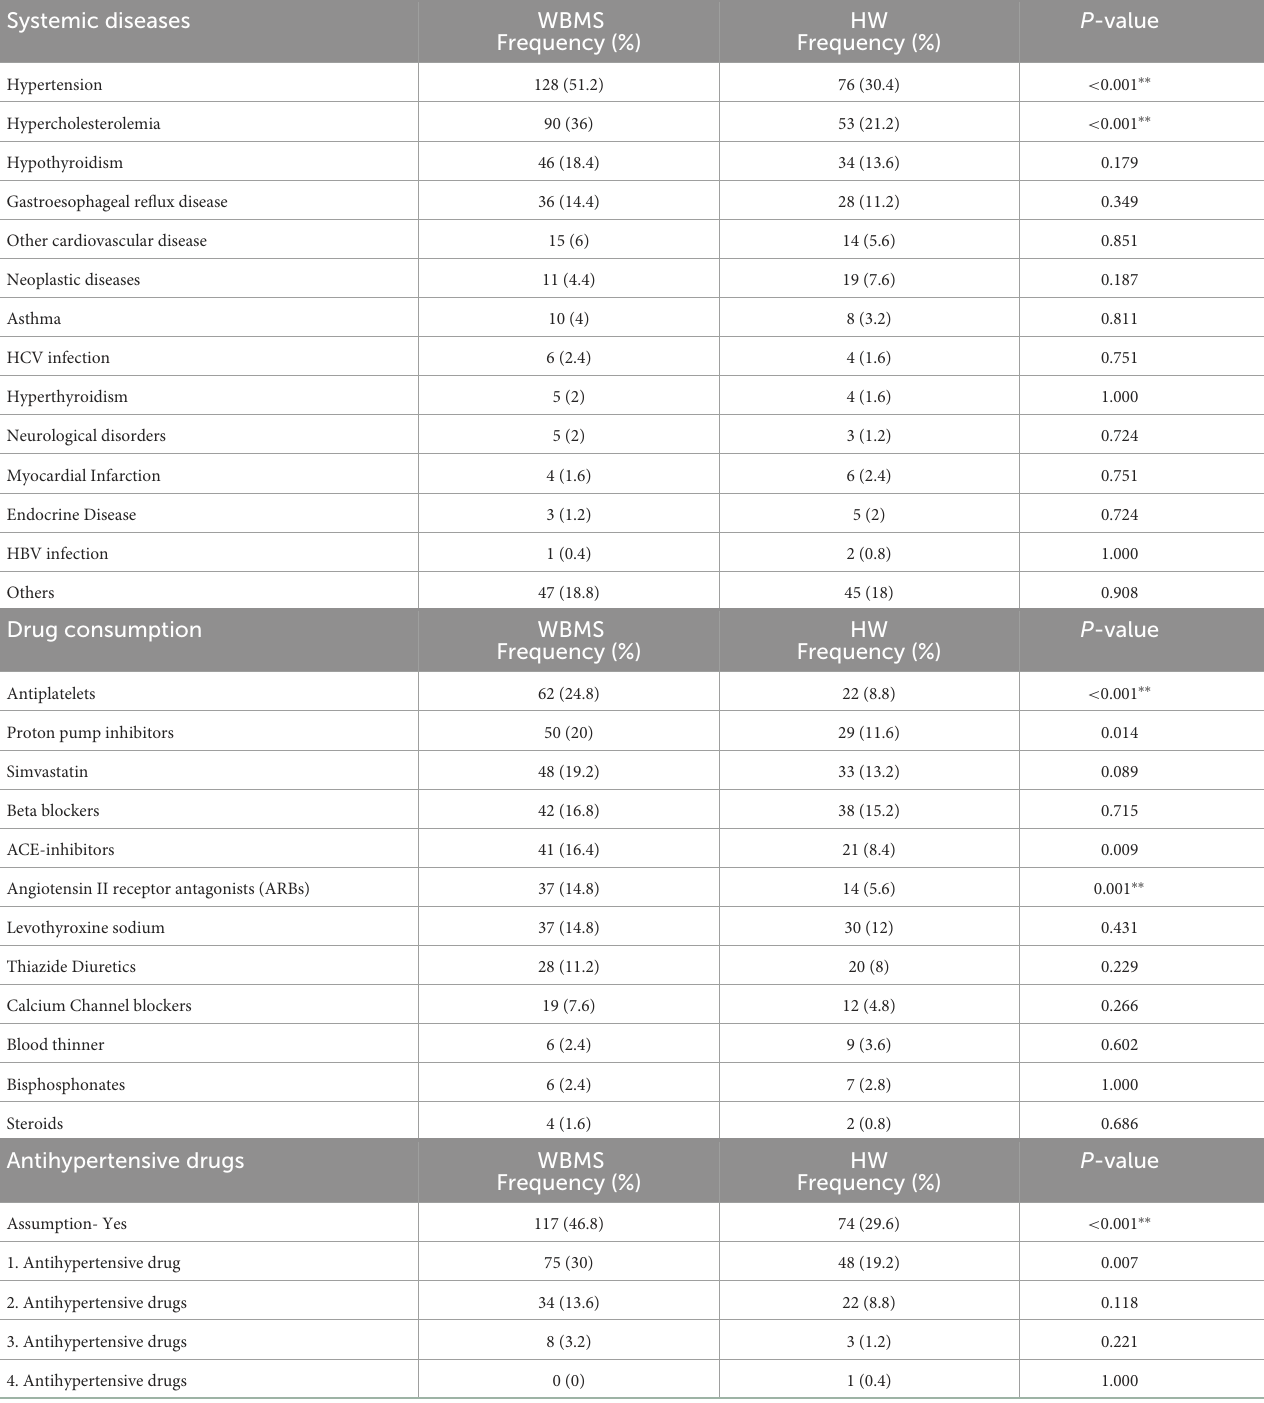
TABLE 2 Prevalence of systemic diseases, drug consumption and antihypertensive drugs evaluation in 250 WBMS patients and 250 HW. Systemic diseases WBMS